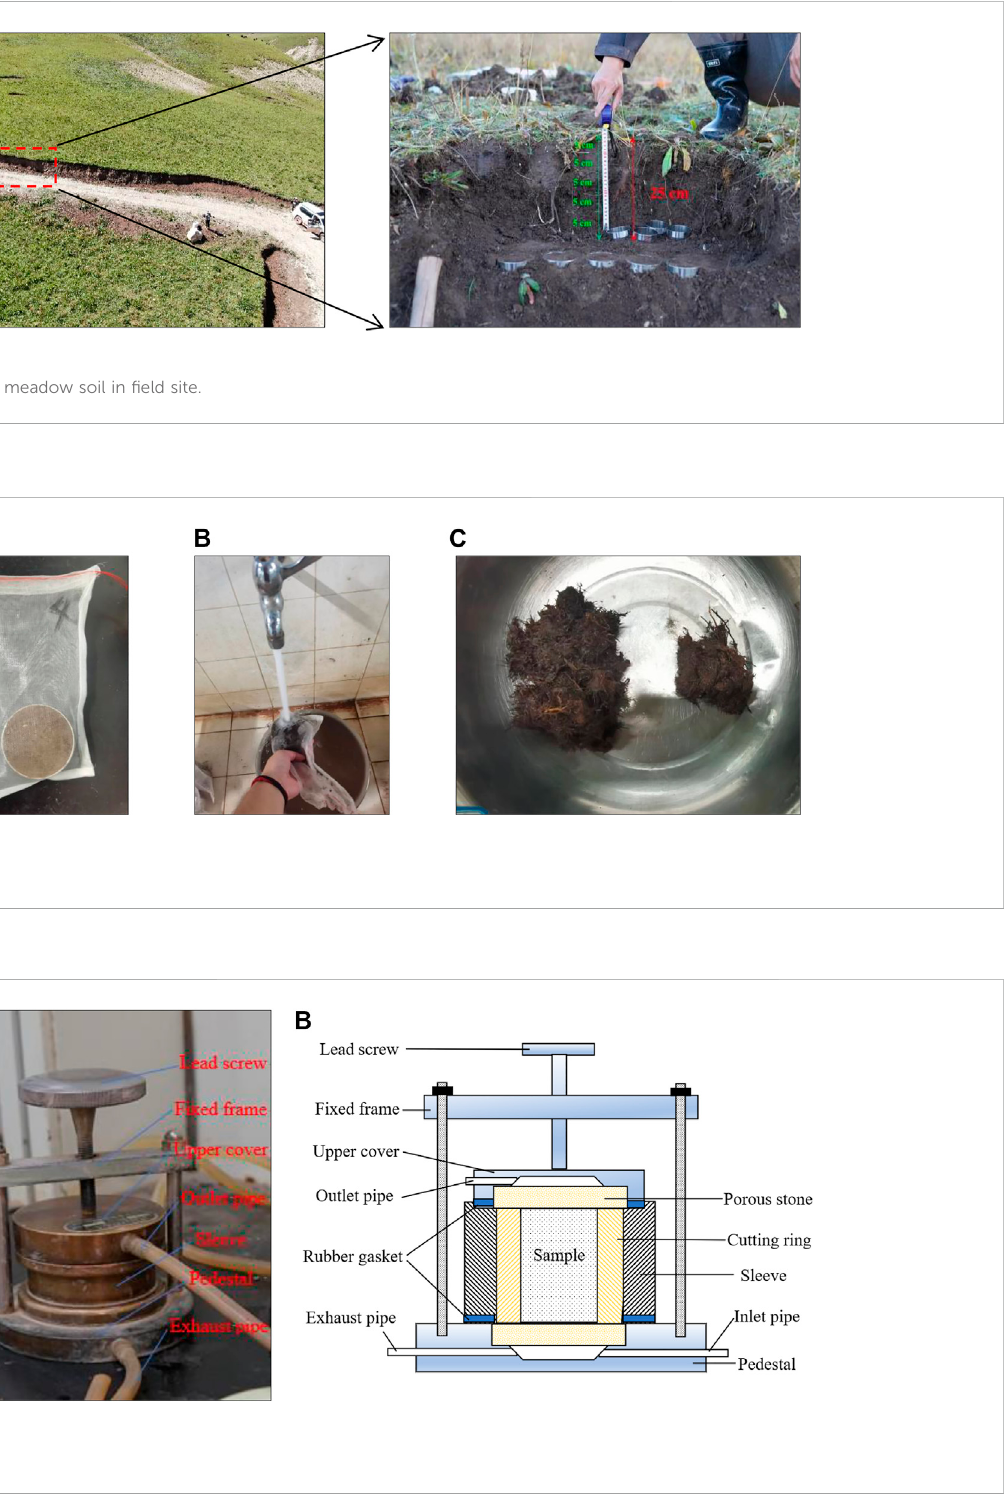
ST55-2 permeability